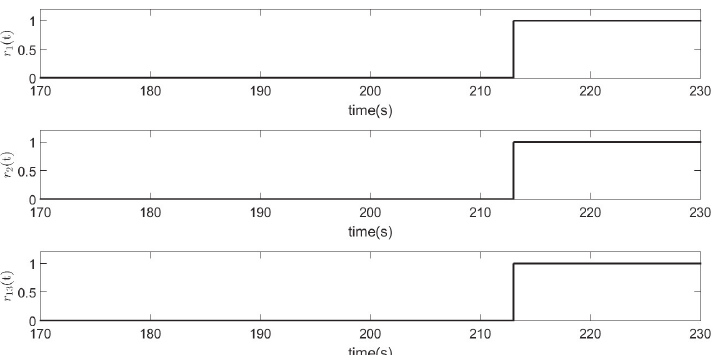
Figure 8. Normalized residual evaluation in case 2 (fault at sensor 1, f s 1 ).